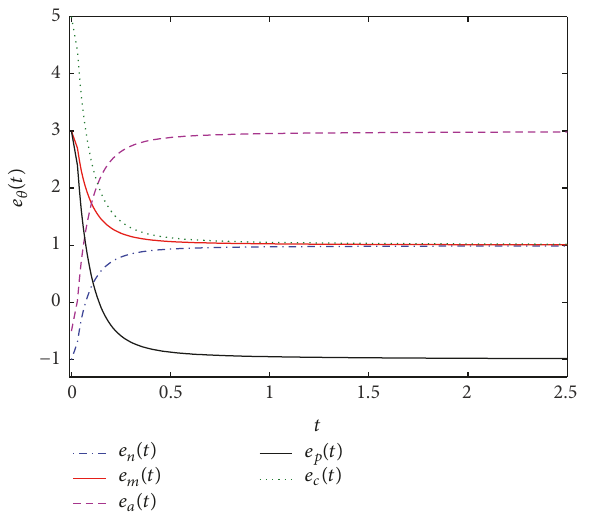
Figure 3: Unknown parameters of system (31) with ℎ 1 (𝑡) = 0.1 cos (2𝑡) and ℎ (𝑡) = 3 √ 𝑡 . 2